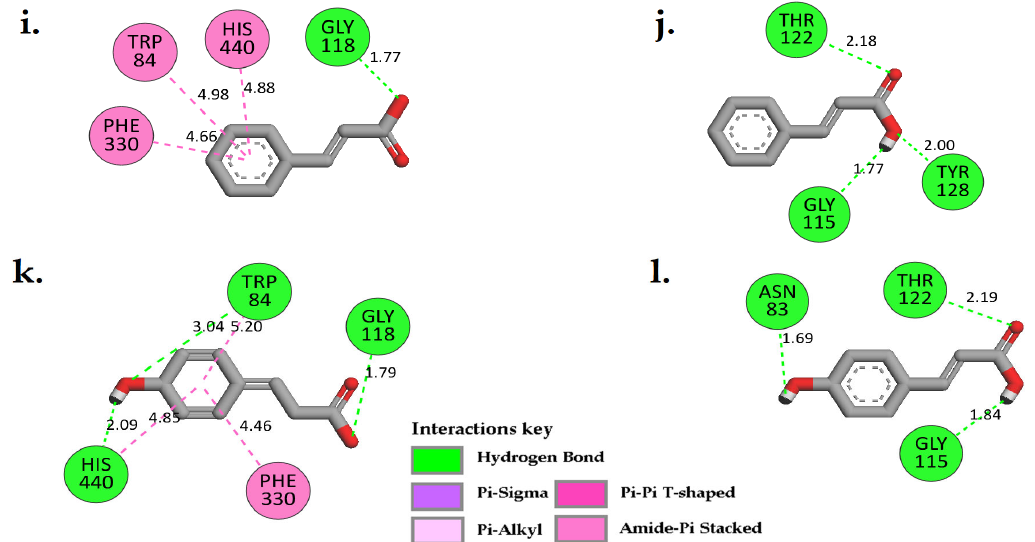
Figure 4. Two-dimensional interaction analysis for the docked complex towards TcAChE: ( a ) galan- tamine, ( c ) 2 , ( e ) 3 , ( g ) 4 , ( i ) 5 , and ( k ) 6 ; and HsBChE ( b ) galantamine, ( d ) 2 , ( f ) 3 , ( h ) 4 , ( j ) 5 , and ( l ) 6 enzymes using BIOVIA Discovery Studio Visualizer.